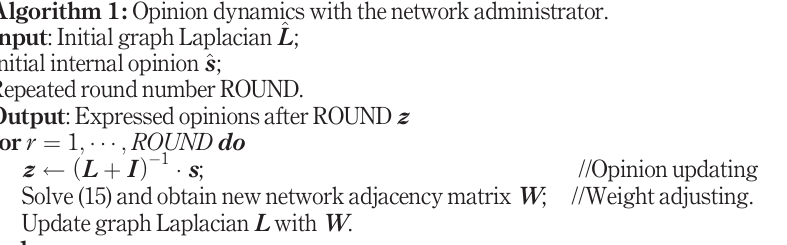
Algorithm 1: Opinion dynamics with the network administrator.